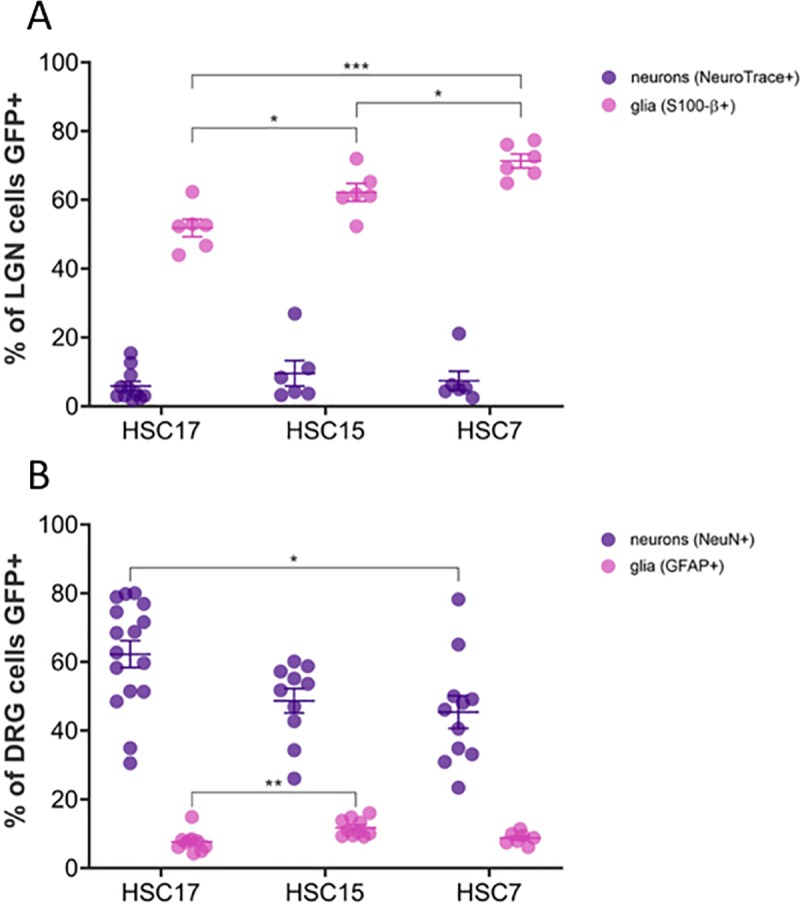
Variation in the transduction efficiency of glia and neurons in the central and peripheral nervous systems.(A) Quantitation of eGFP immunostaining in the LGN of the CNS [S100-β+ (glia); n = 6 sections of tissue from 1–2 animals/capsid; NeuroTrace+ (neurons); n = 6–11 sections of tissue from 1–2 animals/capsid]. (B) Quantitation of eGFP staining in the DRG of the PNS [GFAP+ (glia); n = 7–10 sections of tissue from 1–2 animals/capsid; (NeuN+ (neurons); n = 10–16 sections of tissue from 1–2 animals/capsid). For scAAVHSC7-CBA-eGFP, tissue from one animal was stained. Individual data points are shown along with mean ± SEM. *p < 0.05; **p < 0.005; ***p < 0.001; one-way ANOVA with Tukey’s multiple comparisons test. All glia counts were within 100 μm x 100 μm areas and DRG neuron counts were within 200 μm x 200 μm. For these, each data point represents the average of counts from 3 ROIs within a single image. For neuron counts in LGN, each data point represents counts from an entire single image (500 μm x 500 μm). HSC17 = scAAVHSC17-CBA-eGFP, HSC15 = scAAVHSC15-CBA-eGFP, HSC7 = scAAVHSC7-CBA-eGFP.